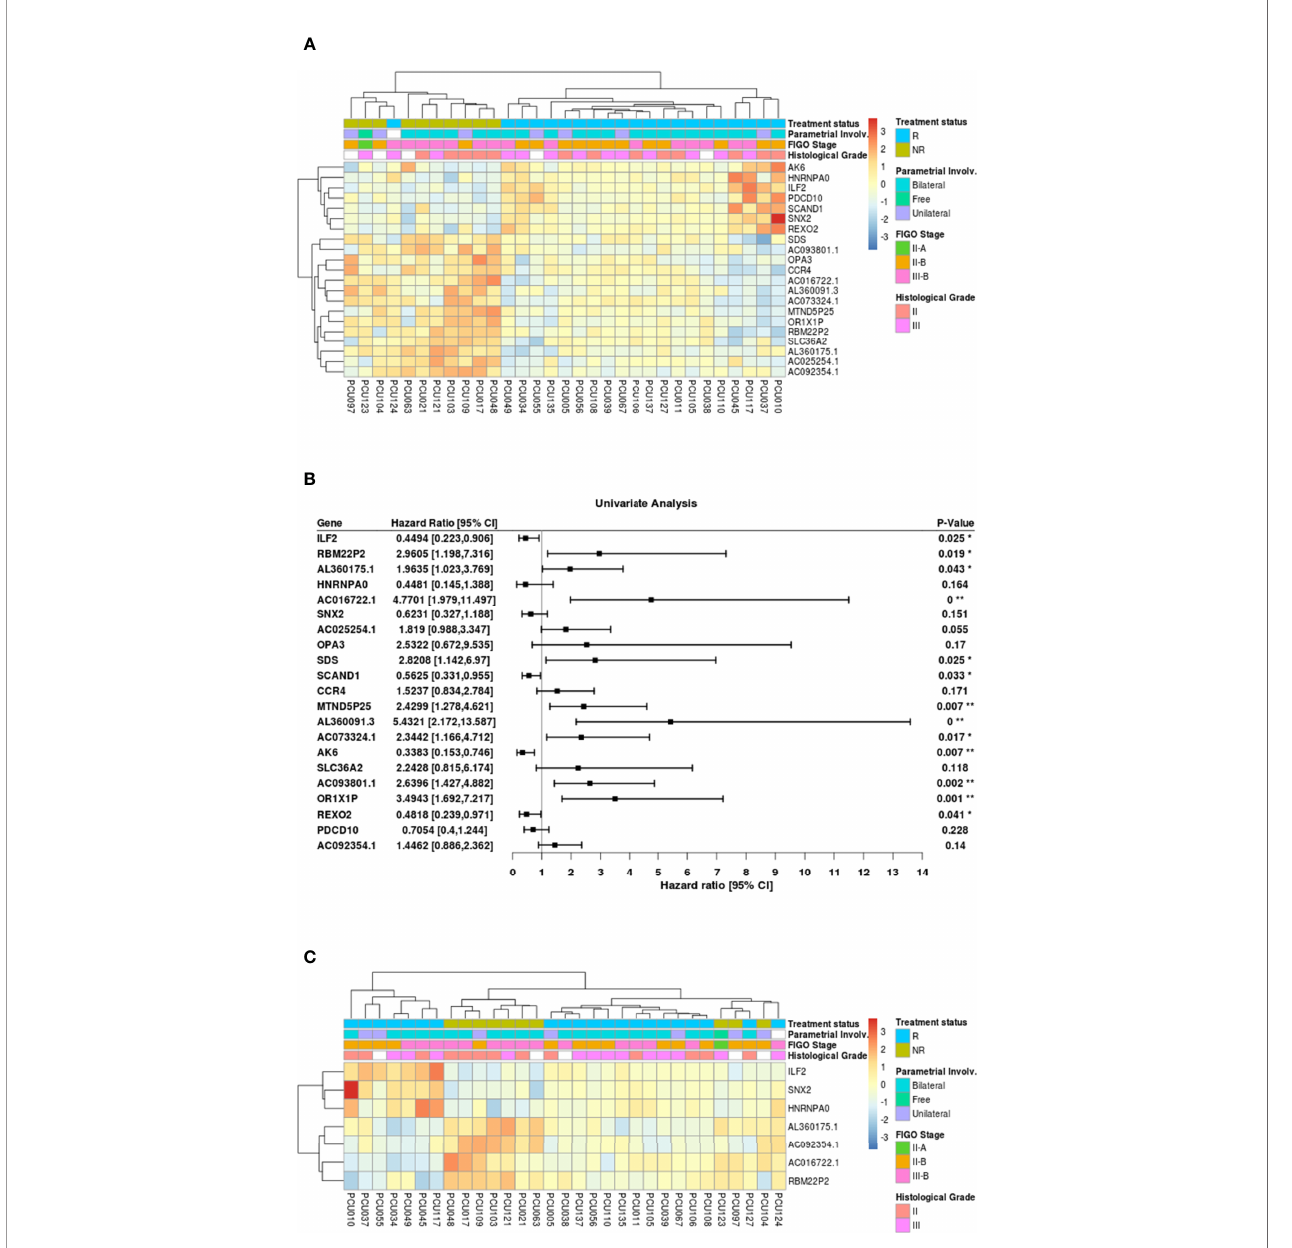
FIGURE 6 | (A) Heatmap of the 21 genes with highest values of partial area under the ROC curve (pAUC, 0.1) from the 1050 differentially expressed transcripts (adjusted p-value<0.05) in cervical cancer stem-like cells. Responders patients (R, n=21) are represented in blue and Non-Responders (NR; n=10) are represented in green. Clinical features of Parametrial involvement, FIGO stages and Histological grades are detailed. (B) Forest plot for prognostic effect of the 21 highest pAUC differential expressed genes in cervical cancer stem-like cells using a univariate analysis. (C) Heatmap showing the 7 overlapping differential expressed loci (adjusted p-value <0.05) between pAUC (0.1) and AUC in cervical cancer stem-like cells. Responders patients (R) are represented in blue and Non-Responders (NR) are represented in green. Clinical characteristics of parametrial involvement, FIGO stages and Histological grades are detailed. (* < 0.05, ** <0.01 and 0** <